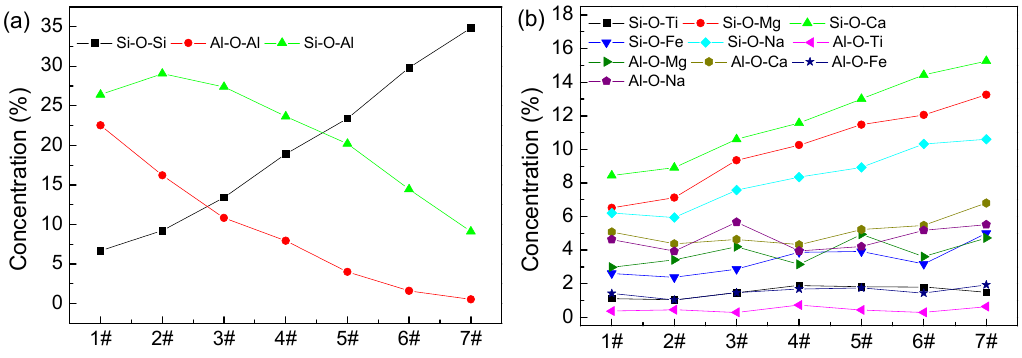
Figure 5. Distribution of BO and NBO in molten red mud: ( a ) BO and ( b ) NBO.